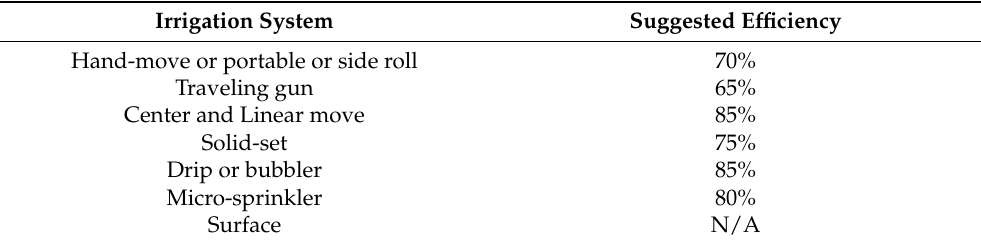
Table 2. Suggested irrigation efficiencies based on pressurized irrigation system